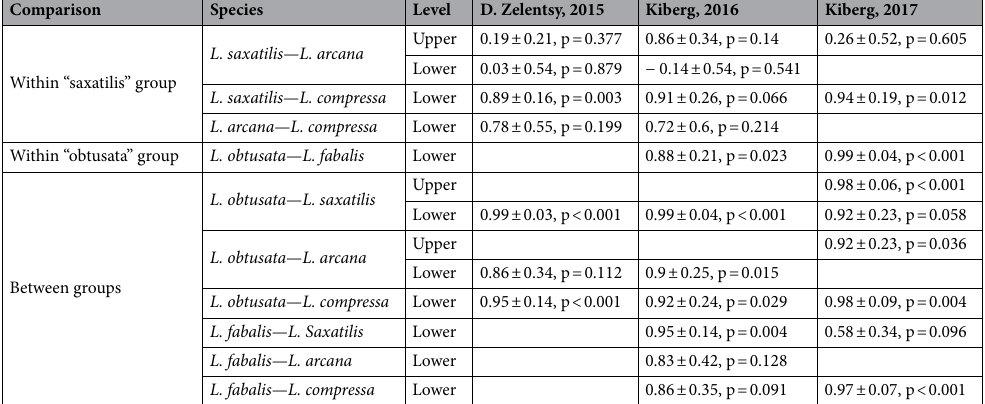
Table 5. Precopulatory Isolation Index within and between Littorina “saxatilis” and “obtusata” species categorized by site and littoral zone. I PC describes total premating isolation; its value varies between − 1 and 1 (− 1—disassortative mating, 0—random mating, 1—assortative mating). L. saxatilis males with 1.5 penial rows were excluded from the analysis. Bootstrap means ± standard deviations are given; p —the two-tail probability of rejecting H 0 : I PC = 0 in the test using bootstrap with 10 000